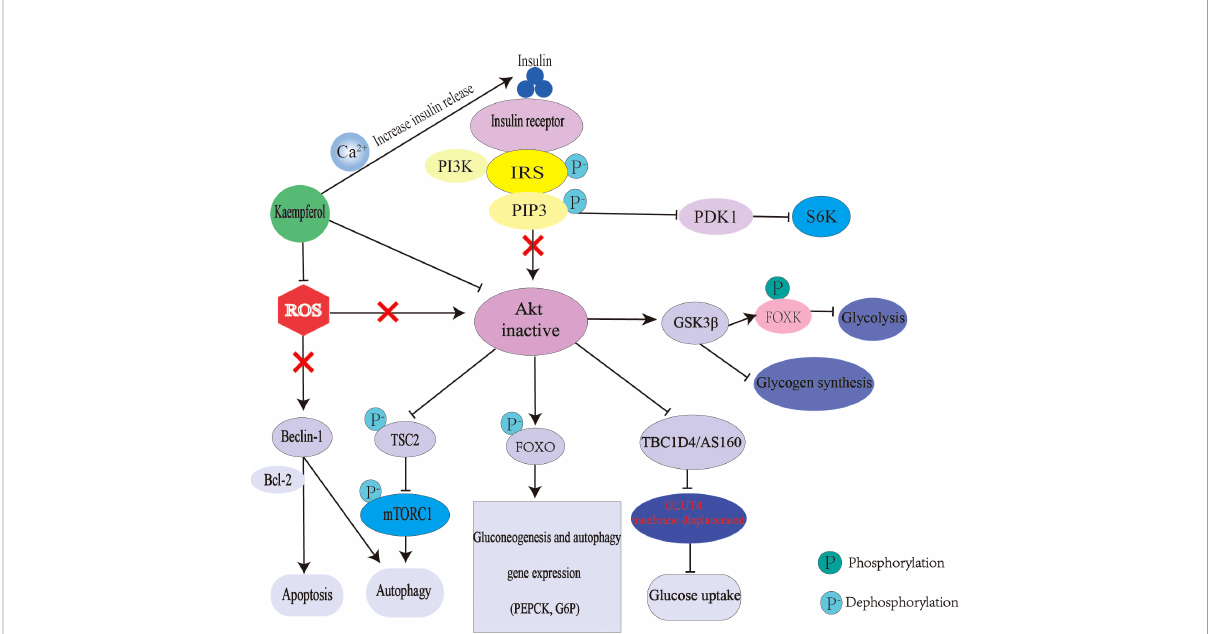
FIGURE 3 Mechanism of kaempferol hypoglycemic. In diabetes, insulin signal transduction is blocked. The expression of gluconeogenesis gene was up- regulated and liver glucose output was excessive. The decrease of glycogen synthesis and glucose uptake makes glucose output greater than consumption, which leads to hyperglycemia. Kaempferol promote insulin secretion and improve Akt activity by regulating mitochondrial calcium uptake. Kaempferol can also directly restore the activity of Akt. Thus reversing the up regulation of gluconeogenesis, down regulation of glycogen synthesis and glucose uptake caused by Akt inactivation. Moreover, kaempferol antioxidant can also regulate autophagy and apoptosis. IRS, Insulin receptor substrate; PI3K, inosine phosphate 3-kinase; AKT; threonine protein kinase; PIP3, phosphatidylinositol 3,4,5-trisphosphate; PDK1, 3- phosphoinositide-dependent protein kinase 1; S6K,ribosomal protein S6 kinase; GSK3 b , Glycogen synthesis kinase 3 b ; FOXO, Forkhead box 0; FOXK, Forkhead Box Class K; TSC2, tuberous sclerosis 2; ROS, reactive oxygen species; Tbc1d4/AS160, Akt substrate of 160 kDa; BCL-2, B cellleukemia/lyrnphoma-2; mTORC1, rapamycin complex1; PEPCK, phosphoenolpyruvate carboxylase; G6P,